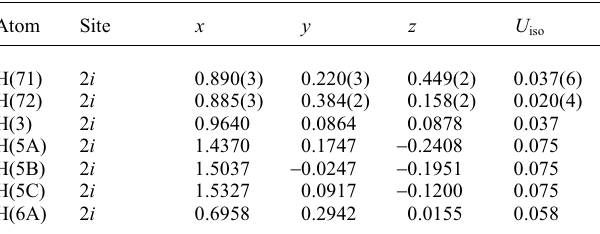
Table 2. Atomic coordinates and displacement parameters (in Å 2 )